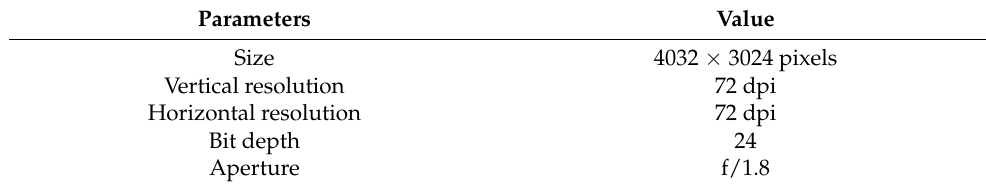
Figure 3. The test structure. Figure 4. Image processing and labeling. ( a ) Original images; ( b ) Cropped images; ( c ) Labeled image.